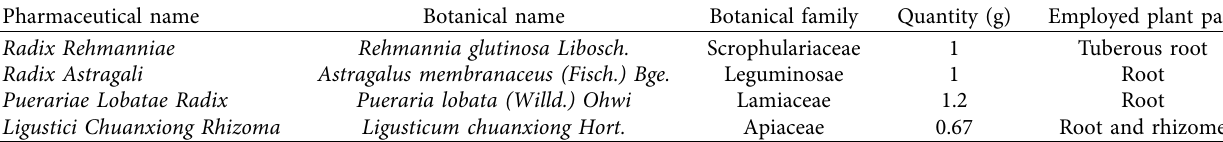
Table 1: The herbal composition of YYTN simplified